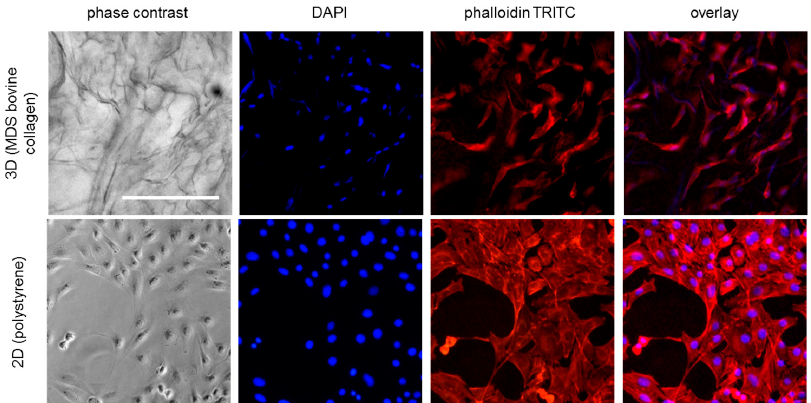
Figure 2. Microscopic images of NIH 3T3 fibroblasts in standard 2D culture on polystyrene surface and in 3D culture on MDS bovine collagen matrix (48 h incubation; 35,000 cells/cm² seeding density). Cells were stained with DAPI (blue, nuclei) and TRITC-conjugated phalloidin (red, f-actin). Scale bar represents 250 µm.